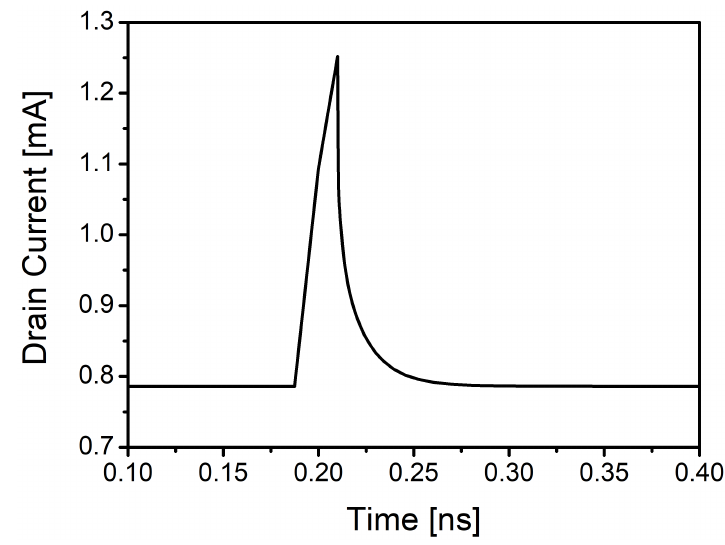
Figure 3. Technology computer-aided design (TCAD)-simulated current pulse in the drain of the transistor due to a heavy ion impact.